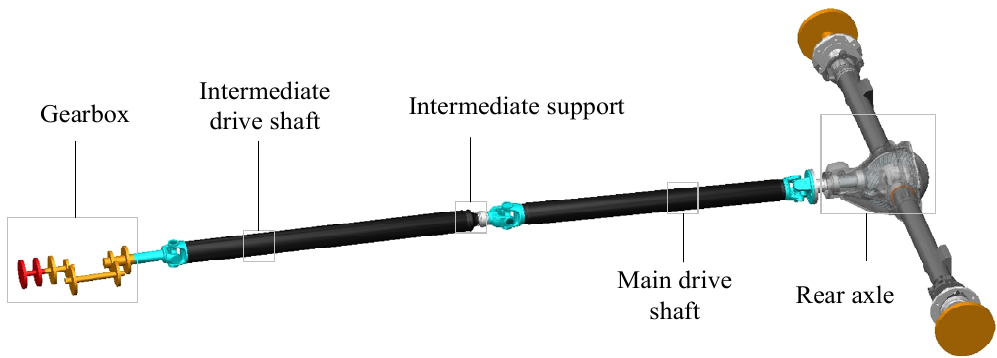
Figure 1. Structural model of the transmission system.